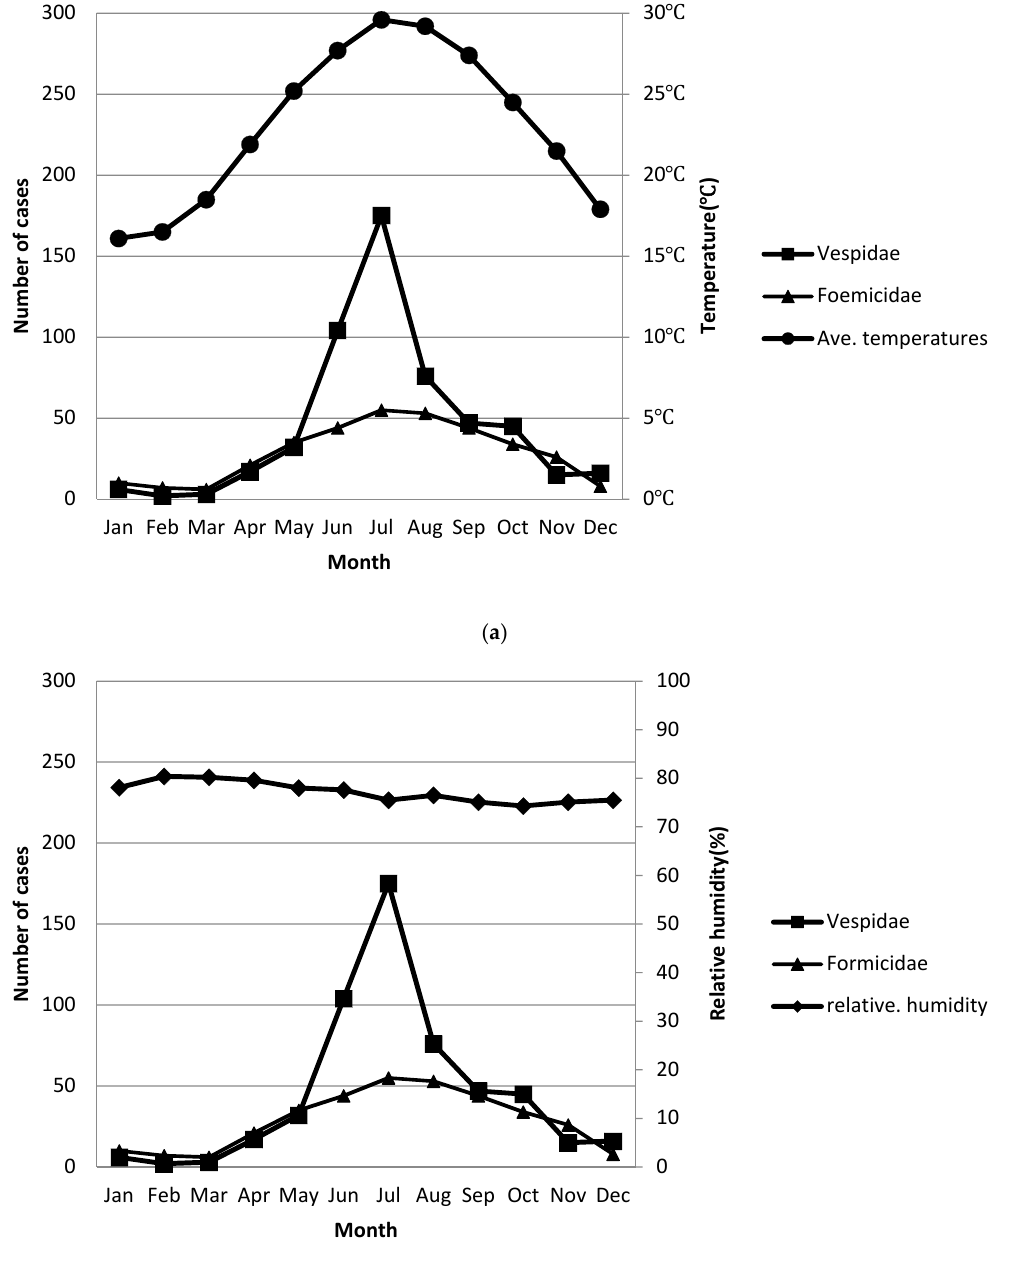
Figure 2. Distribution of cases and monthly average temperature and relative humidity by month (case numbers are depicted by month). ( a ). The case numbers of both groups by month show a strong positive association with average (Ave.) monthly temperature. ( b ). The case numbers of both groups by month shows a slightly negative association with monthly relative humidity.